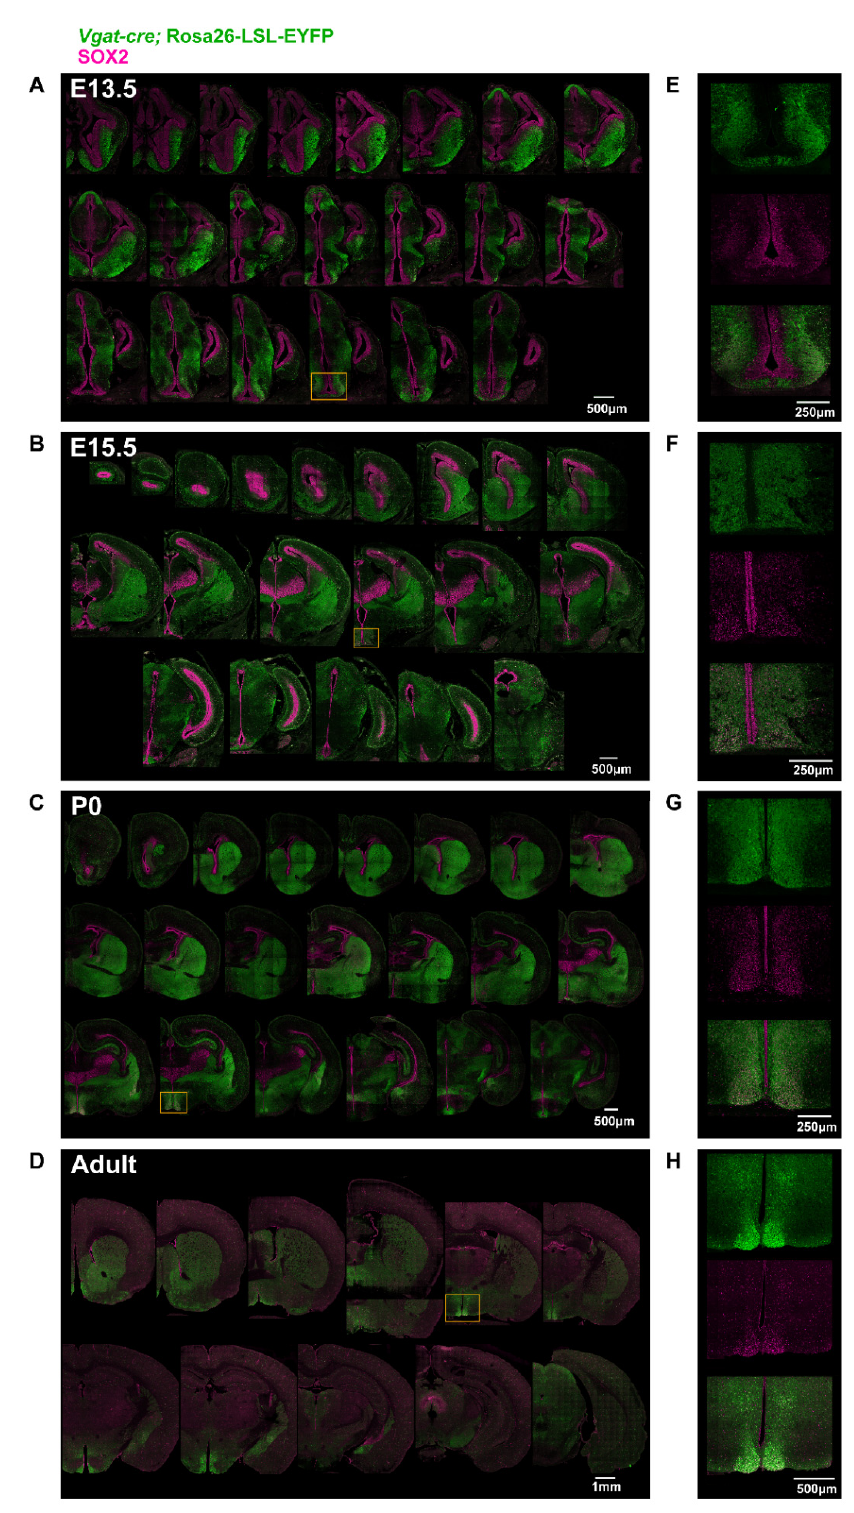
Figure 1. Expression pattern of VGAT and SOX2 in the developing and adult mouse brain. ( A – H ) Representative photomicrographs of EYFP (proxy for VGAT; green) and SOX2 (magenta) expression in the brains of Vgat-cre;Rosa26-LSL-EYFP mice at ( A , E ) E13.5, ( B , F ) E15.5, ( C , G ) P0, and ( D , H ) the adult stage along the rostral-caudal axis ( A – D , from top left to bottom right). Orange rectangles highlight the hypothalamic region containing the developing or mature SCN, which is given in higher magnification in ( E – H